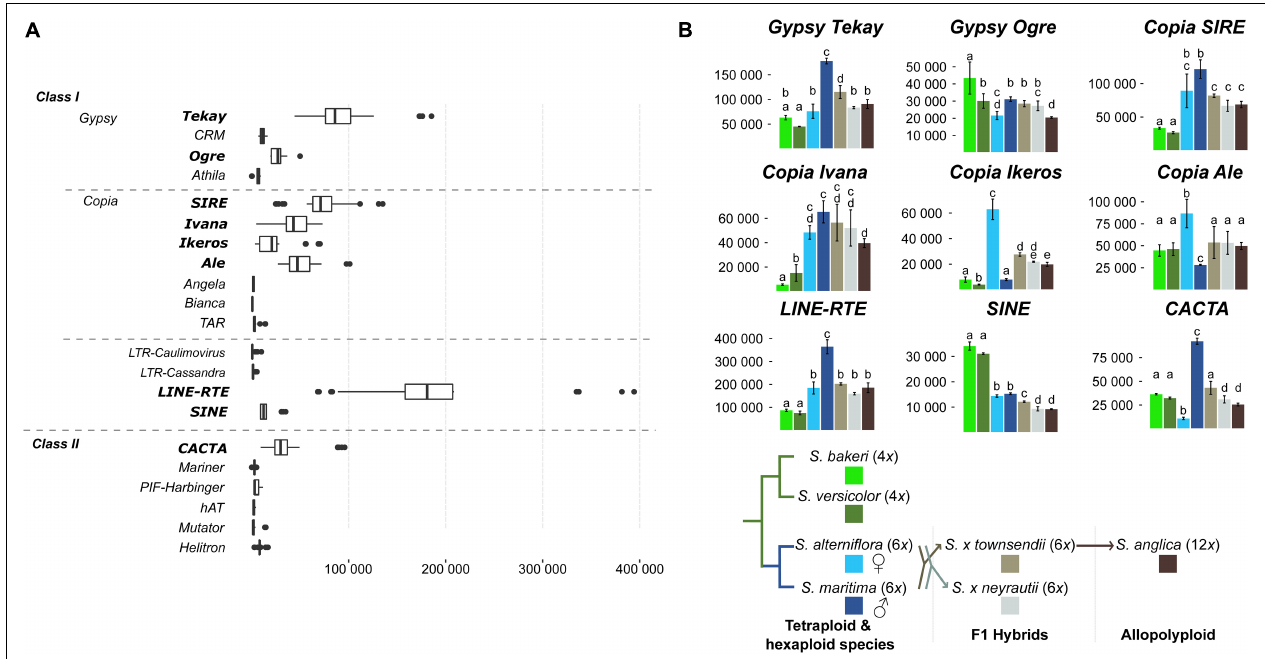
FIGURE 7 | Expression of transposable elements. (A) Expression levels comparison between all TEs identified in the Spartina genomes (Giraud et al., 2020). Boxplots were calculated from TE expression levels (normalized reads count) considering each library of all studied species. (B) Variation of TE expression levels between species. Only the nine highest expressed TEs are shown ( p -value < 0.01). Letters above bars (from a – e ) indicate significant differences of TE expression between